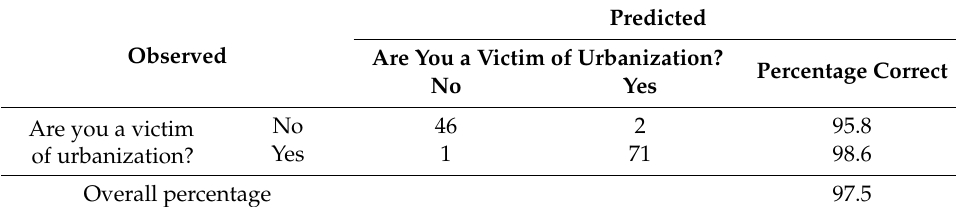
Table 5. Classification